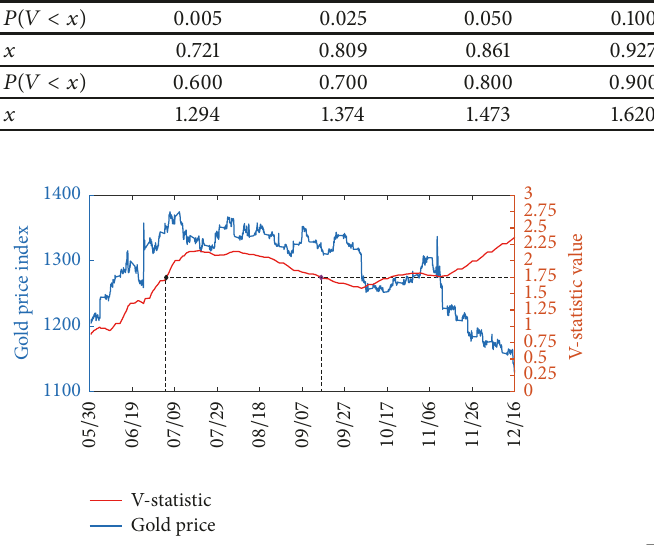
Figure 5: Moving 𝑉 𝑛 (𝑡,𝑠) -statistic evaluated for the volatilities of XAU/USD.